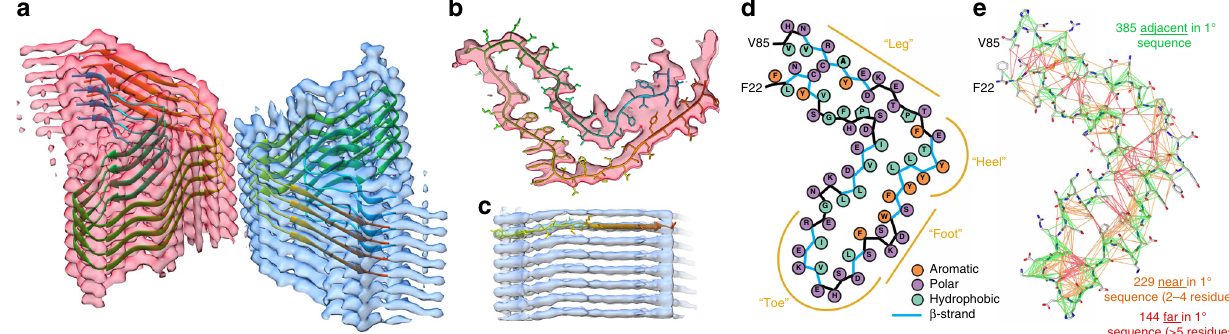
Fig. 3 The structure of a β 2 m amyloid fi bril. a Oblique view of the cryo-EM map, with four layers of a de novo atomic model built into each proto fi lament (coloured pink and blue). The view matches the green section in Fig. 2b. b Cross-section and c side view of a single layer of the atomic model, showing the fi t of model to density across the β β 2 m subunit. d Schematic view of a single 2 m subunit showing polar (purple), hydrophobic (cyan), and aromatic residues (orange) in the fi bril core. The position of β -strands is indicated by a blue backbone in the schematic, together with the locations of the toe, foot, heel, and leg terminology used to describe the structure in the main text. e Distance constraints from the MAS-NMR data mapped onto the atomic model derived by